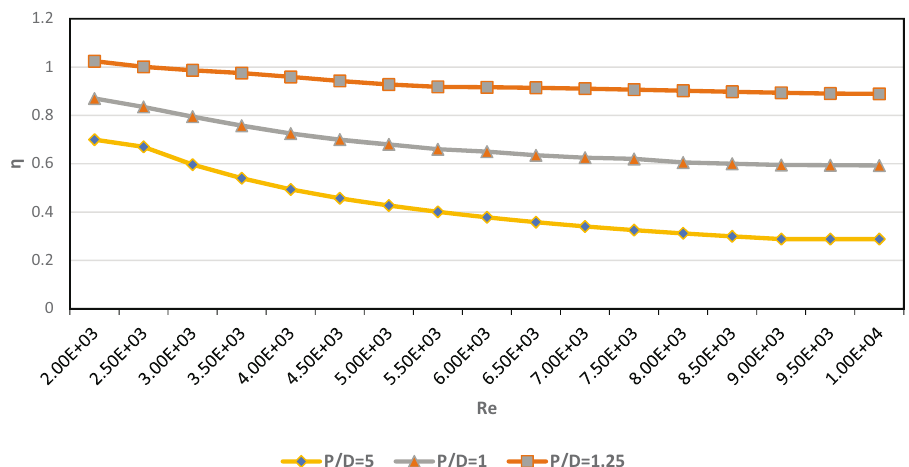
Figure 6: The e ff ect of ba ffl e pitch on heat transfer